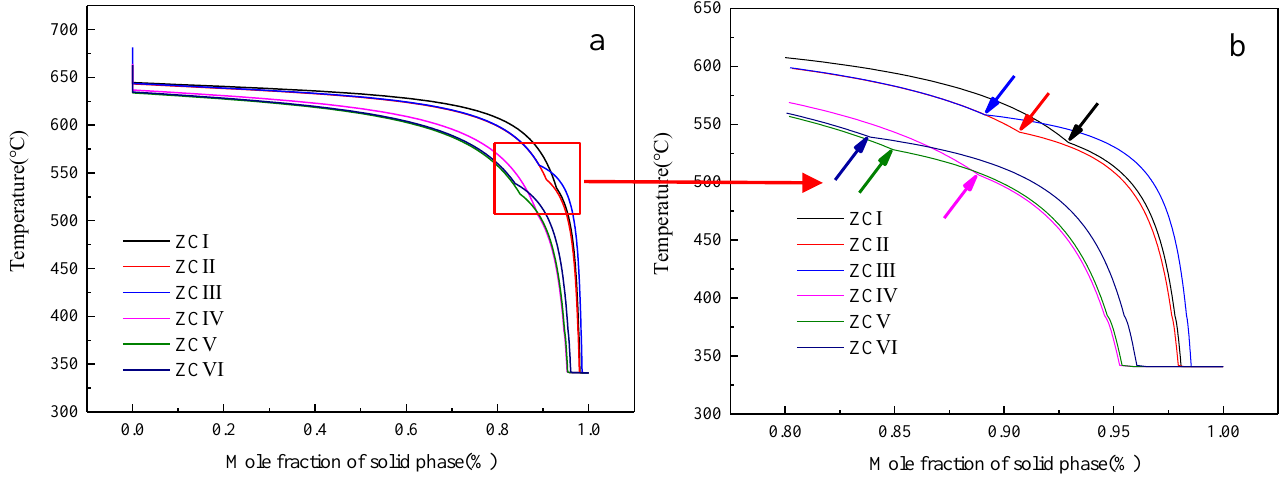
Figure 12. Scheil – Gulliver non-equilibrium solidification model. ( a ) Calculated results of S-G model for experimental alloy, ( b ) Enlarged view of the red area in the figure on the right.